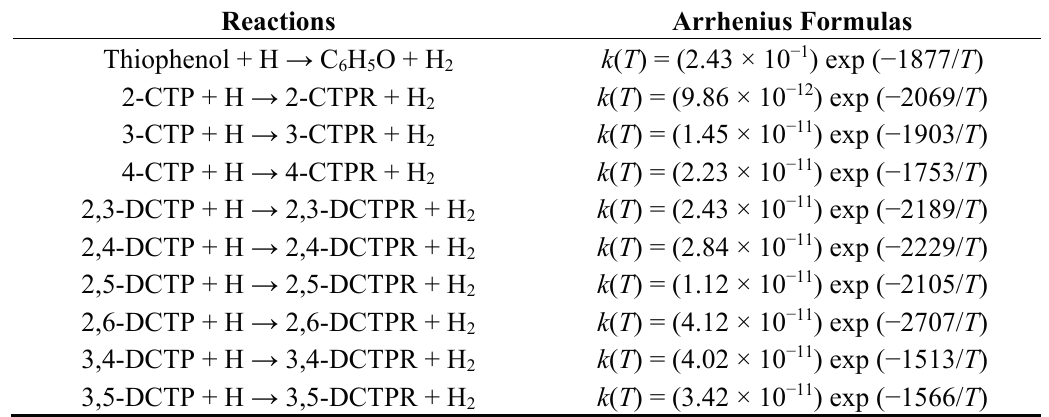
Table 3. Arrhenius formulas (in cm 3 ·molecule − 1 ·s − 1 ) for the thiophenoxyl-hydrogen abstraction from chlorothiophenols and thiophenol by H over the temperature range of 600–1200